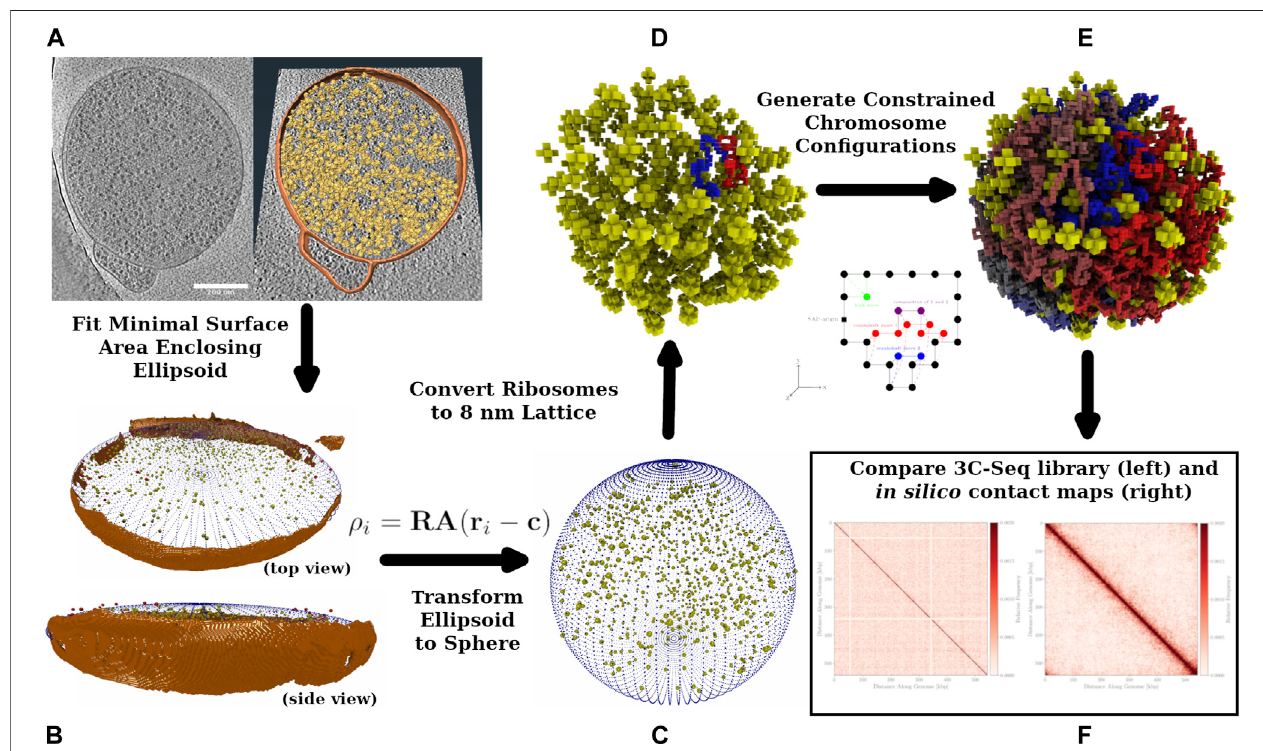
FIGURE 1 | Work fl ow Diagram: Cryo-ET data is used to reconstruct spherical Syn3A cells, constrained chromosome con fi gurations are generated within the reconstructed cells and resulting in silico chromosome contact maps are compared to the experimental 3C-Seq map. (A) : The left side is a single z-slice of the tomographic reconstruction. The right side are the ribosomes (yellow) identi fi ed using template-matching and the membrane segmentation (orange) superimposed on thez-slice. (B) :Theshapeoftheblottedcellsisapproximatedbyanellipsoidthatismanuallycomparedtothetomographicmembranesegmentation(orange).Inan iterative procedure, a series of minimal surface area enclosing ellipsoids (MSAEE) are fi t around the ribosome coordinates while extraneous ribosomes assessed to be outside of the true membrane are removed within each iteration. The fi nal fi tted ellipsoid is shown in blue and the extraneous ribosomes in red. (C) : As Syn3A cells are known to have a spherical morphology, the ribosome coordinates and ellipsoidal membrane approximation are then transformed to a sphere with equivalent surface area. (D) : Thecontinuum representation isthen converted to an8 nm cubic lattice representation used for whole-cell simulationswithLM. (E) : Circular and self-avoiding chromosome con fi gurations are generated as a lattice polymer on a 4 nm cubic lattice. The 4 nm lattice is coincident with the 8 nm cubic lattice and the chromosomes areconstrainedtoavoidtheribosomesandremainwithinthemembrane.IntherepresentativeDNAcon fi guration,monomersarecoloredredandblueonoppositearms of the chromosome. (F) : In silico contact maps from ensembles of generated DNA con fi gurations are compared to the experimental 3C-Seq